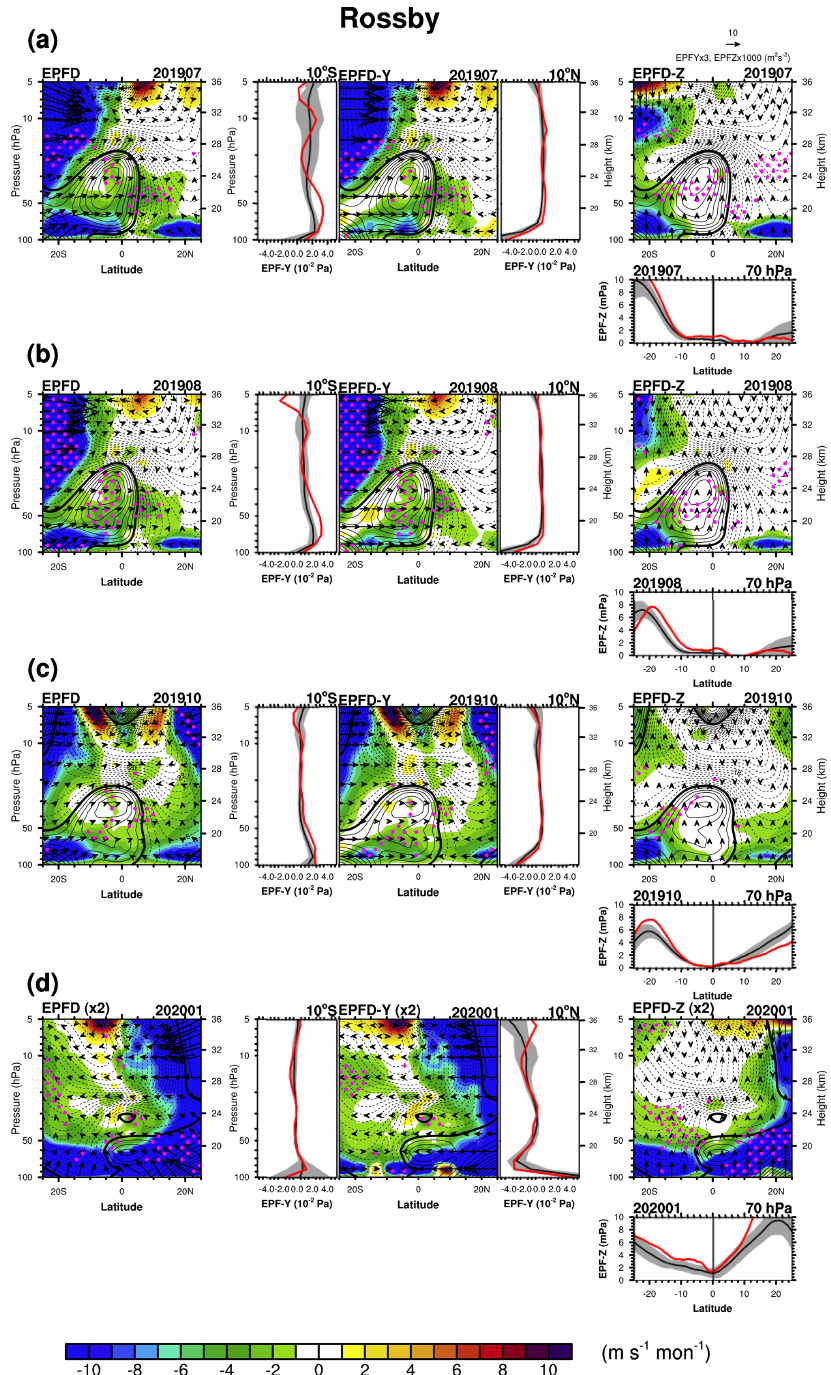
Figure 5. EPF divided by air density (first column; vectors) and EPFD (shading) for the Rossby waves in a latitude–height cross section, along with (second column) their meridional and (third column) vertical components in (a) July 2019, (b) August 2019, (c) October 2019, and (d) January 2020. The vertical profiles of the meridional EP fluxes at 10 ◦ S and 10 ◦ N are presented on the left and right sides of the EPFD- y , and the meridional distribution of the vertical EP flux at 70hPa is presented at the bottom of the EPFD- z (red and black lines correspond to the disruption and the climatology, respectively, with ± 1SD; gray shading). The solid (dashed) lines indicate westerly (easterly) winds with an interval of 2ms − 1 , and thick solid lines indicate a zero zonal wind speed. The magenta stipples represent stronger negative EPFD than the climatology by more than its standard